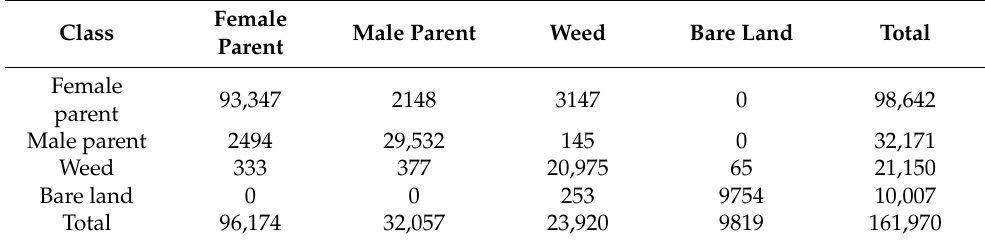
Table 5. Confusion matrix calculation based on ExGR